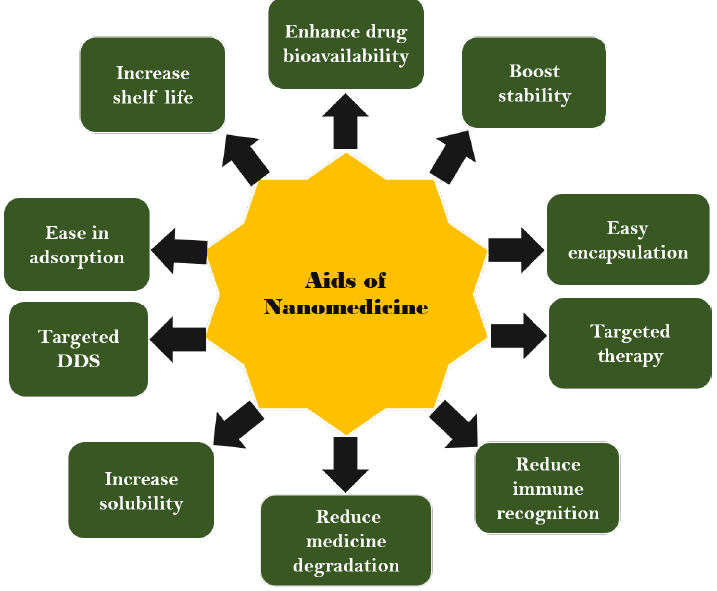
Figure 2. Aids of using nanomedicine platform for delivering drugs to the tumor